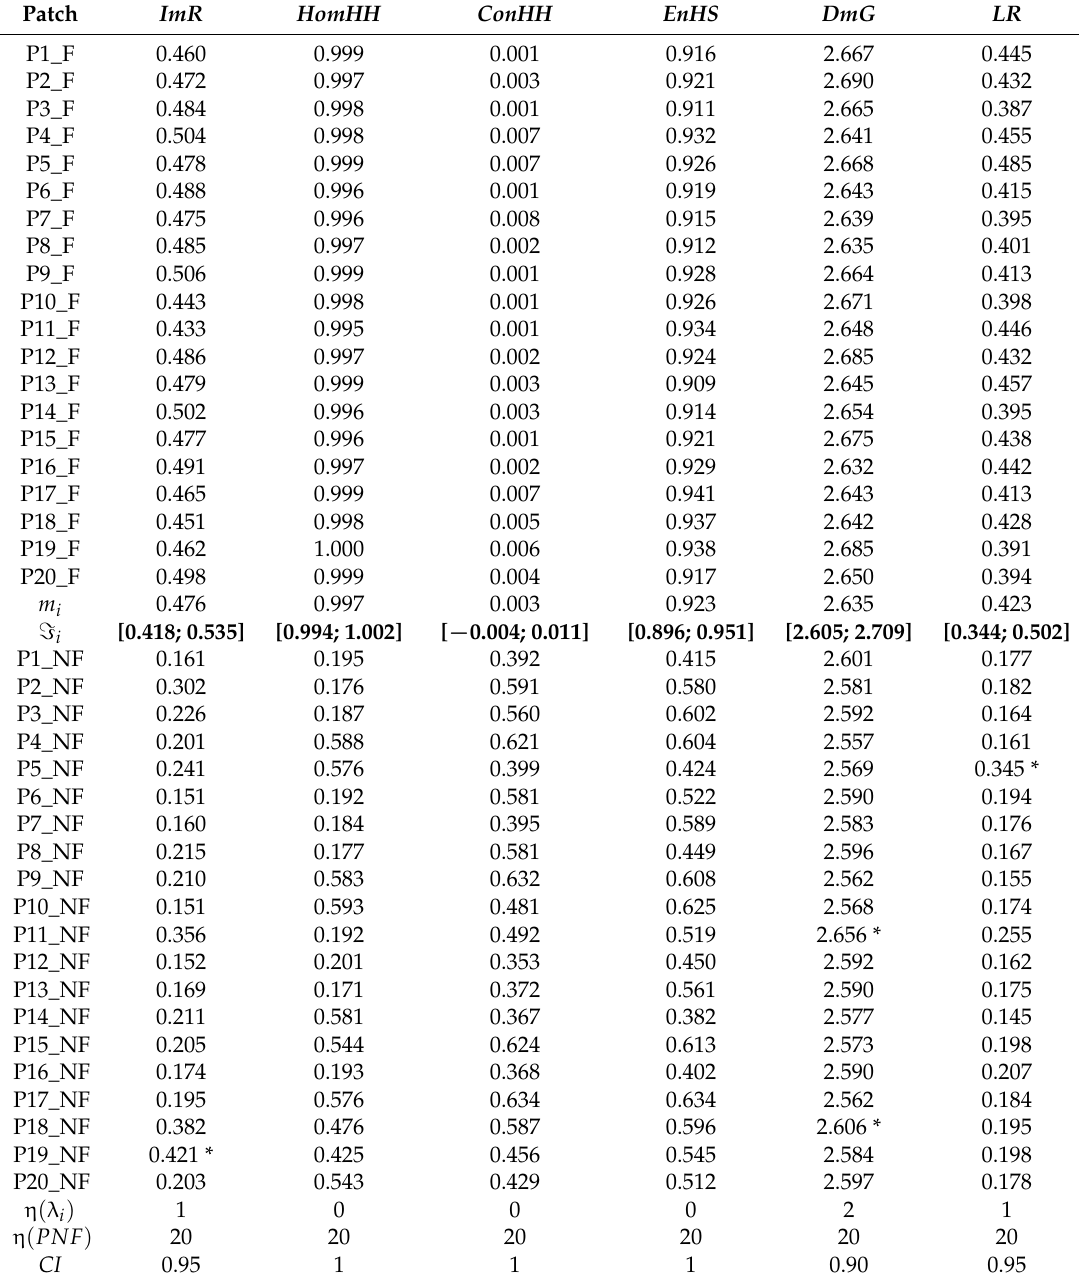
Table 4. The selected features, their confidence indicators and the representatives for the class F .